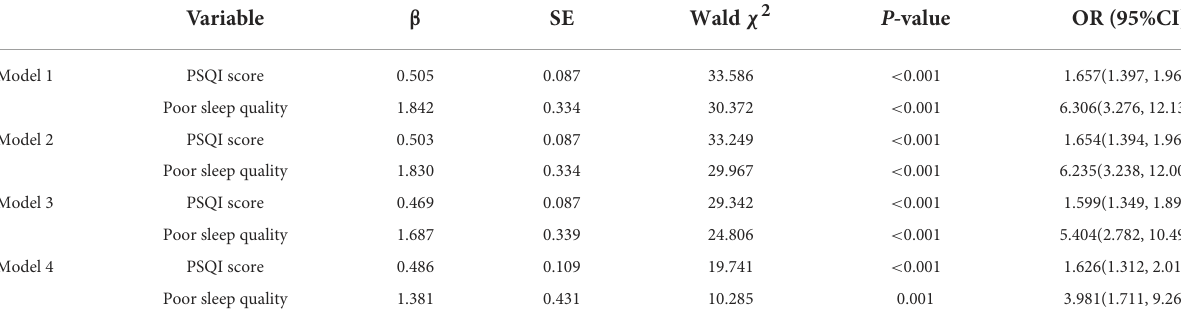
TABLE 2 Multivariate logistic regression analysis of sleep quality on the risk of